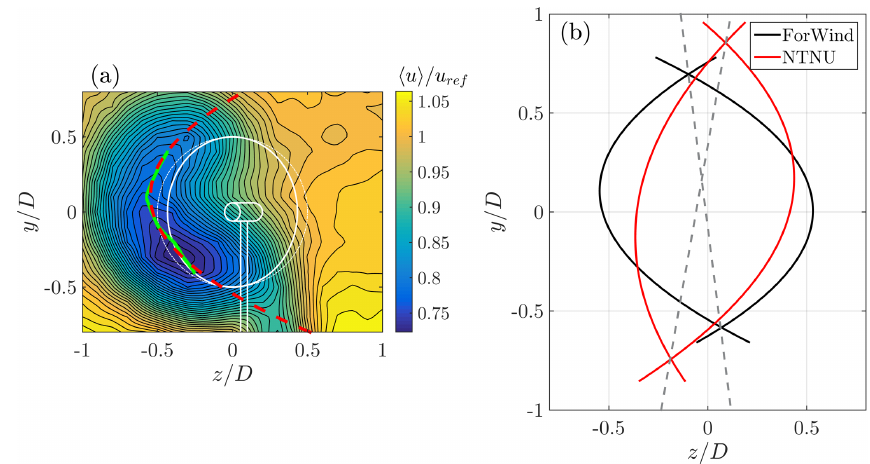
Figure 13. (a) Example of parameterizing the curled shape of the velocity deficit. The green markings show minimal velocities of a polyno- mial function used to fit the interpolated data points in a horizontal line; y is a constant. The red dashed line shows a quadratic fit based on the green markings. (b) Visualization of the curled shapes of the velocity deficits. For both turbines, the cases γ = ± 30 ◦ are shown. Dashed lines show a visualization of the wakes tilt, connecting the respective intersections of the curves.